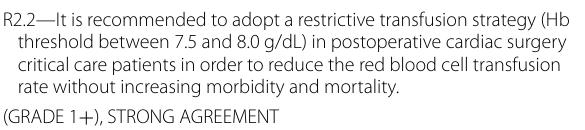
Figure 2 proposes transfusion thresholds adapted to the various populations of critical care patients (Expert opinion). Strong consensus